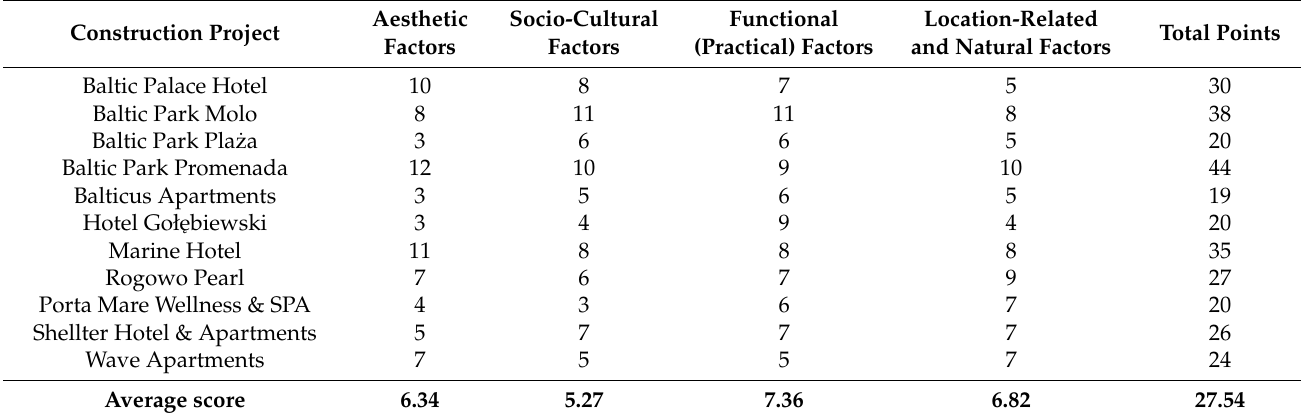
Table 2. Summary of the scores for each construction project analysed using the building evaluation forms (Appendix A). Source: Authors’